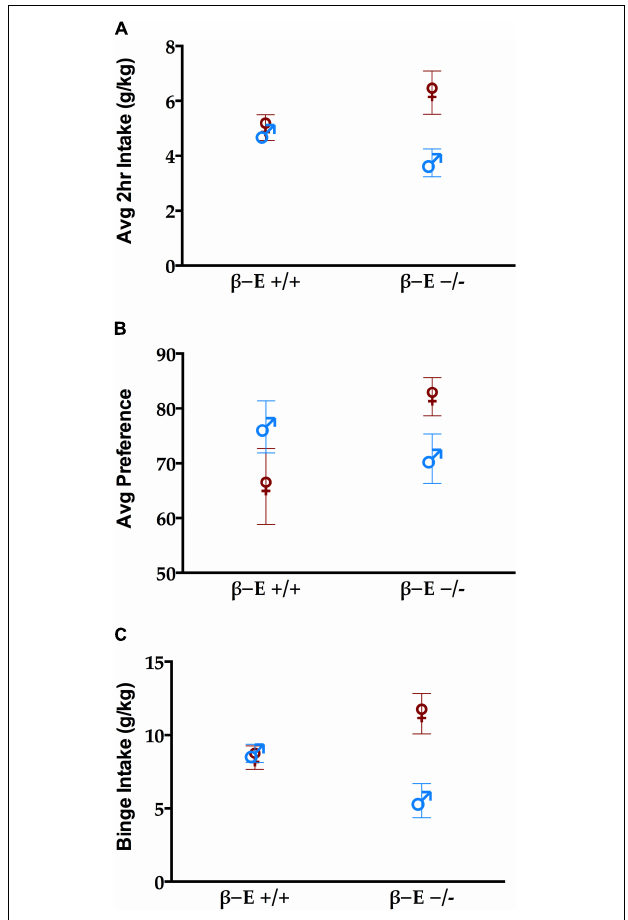
FIGURE 1 | β E masks sex differences in binge-like EtOH consumption. (A) Average 2 h intake across 4 day drinking in the dark (DID). (B) Preference for EtOH solution during the 4 h binge test. (C) Consumption of EtOH during the 4 h binge test on day 4 of the DID procedure. A two-way ANOVA revealed a main effect of sex (female mice > male mice) and a sex by genotype interaction. Post hoc analyses indicated that the β E –/– female